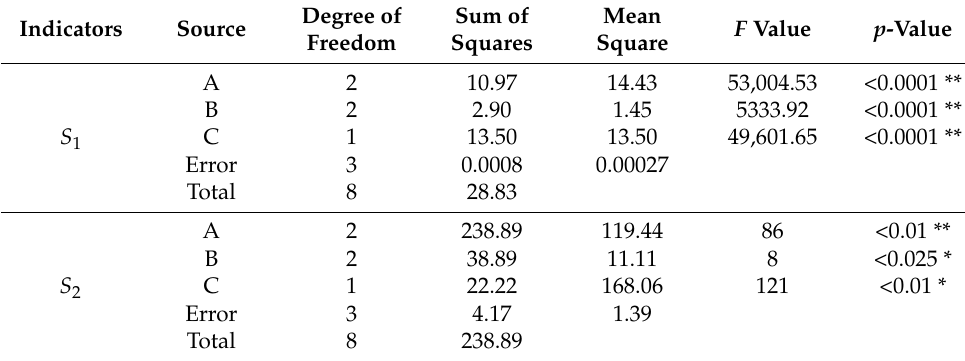
Table 7. Variance analysis of test